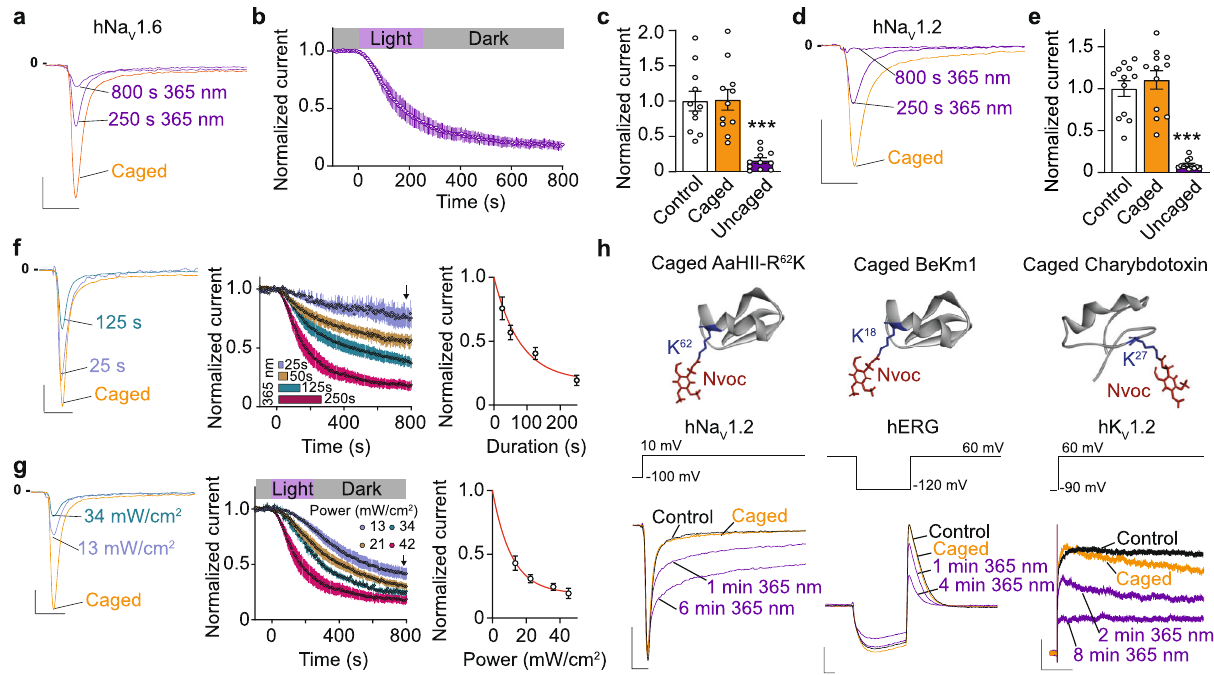
Fig. 4 Modulation of ion channels properties by light-induced uncaging of peptide toxins. a – c Light-induced inhibition of hNa V 1.6 current by photolysis of 100 nM HwTxIV-Nvoc. Note that not all of the HwTxIV-Nvoc is uncaged by photolysis during this exposure time. a Representative recordings of hNa V 1.6 current with caged HwTxIV (orange) and after various illumination times (purple) and ( b ) average normalized time courses of hNa V 1.6 current inhibition during and following light application ( n = 11, mean ± SEM). Scale: 2 ms, 1 nA. c Average normalized current at steady-state in control (dark), caged (orange) and uncaged (purple) conditions ( n = 11, *** p < 0.001, two-sided repeated-measures 1-way ANOVA followed by Bonferroni ’ s post-test.).